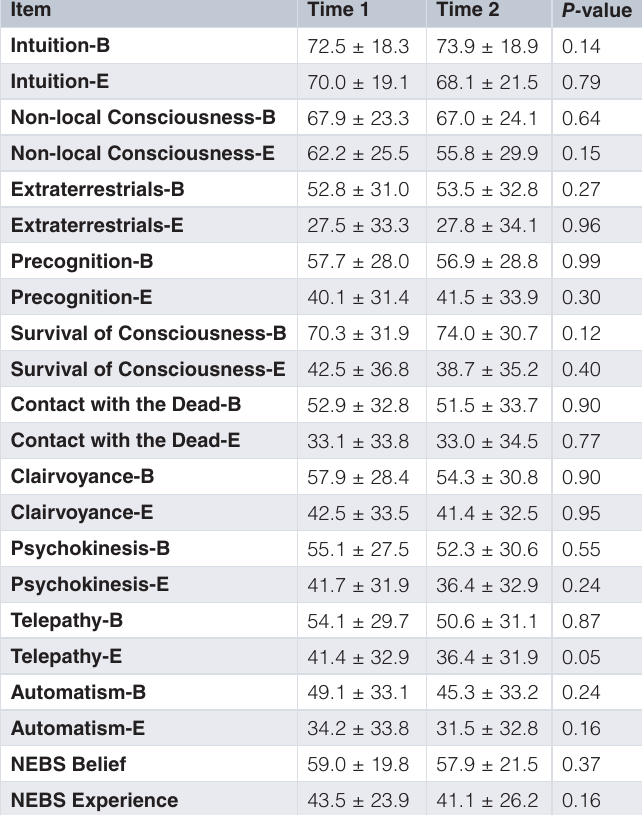
Table 3. Mean values and standard deviations for test-retest. B - Belief; E - Experience; NEBS - Noetic Experience and Belief